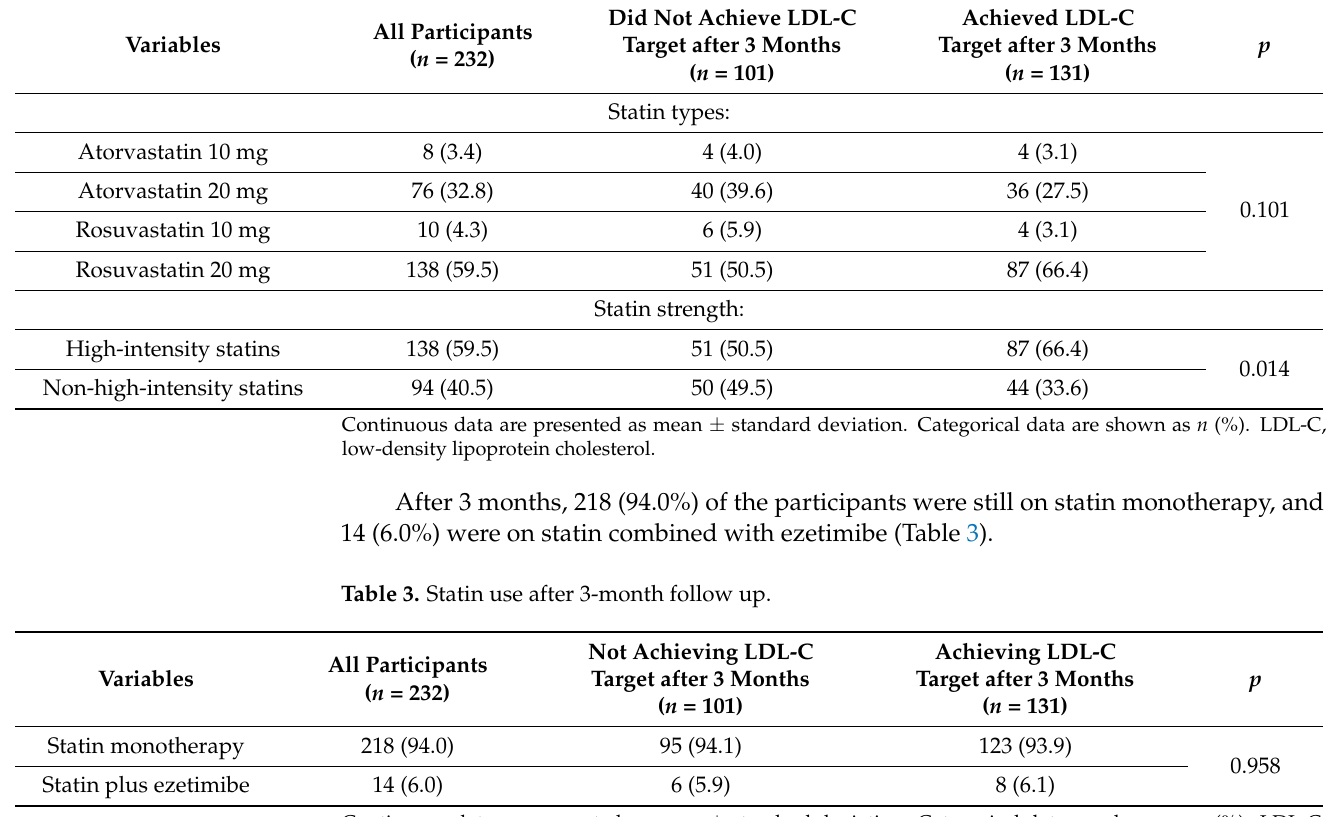
Table 2. Prescription of statin at discharge.